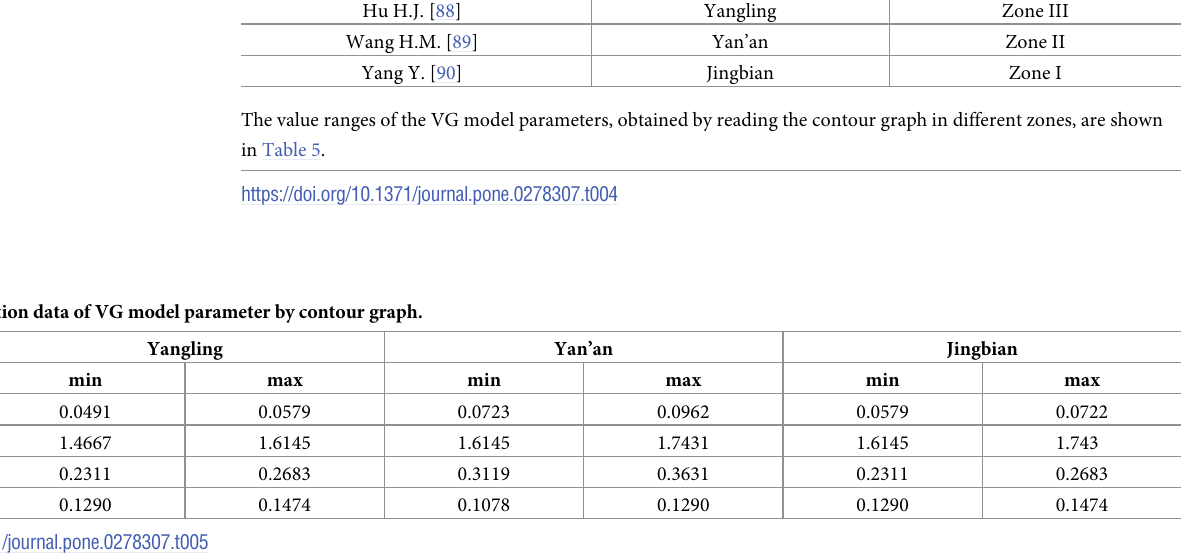
Table 4. Unsaturated permeability coefficient data source.